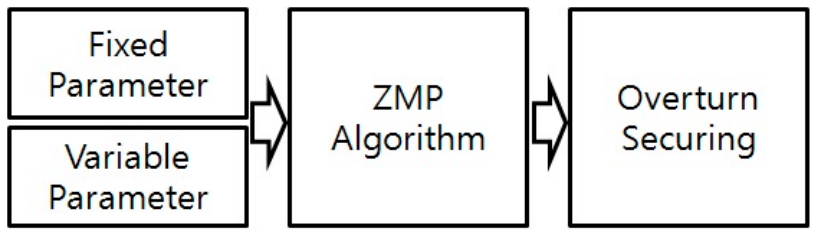
Figure 2. The process of anti-overturn securing algorithms.